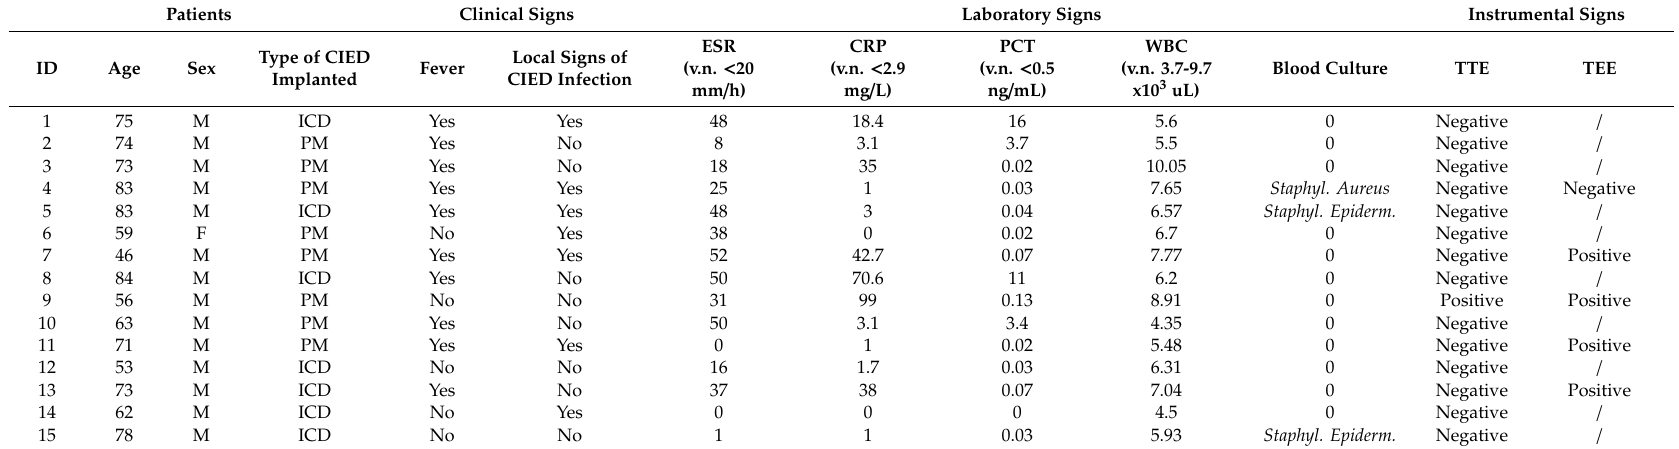
Table 1. Demographic, clinical and instrumental characteristics of cardiac implantable electronic devices infection group (CIEDIsusp) patients.